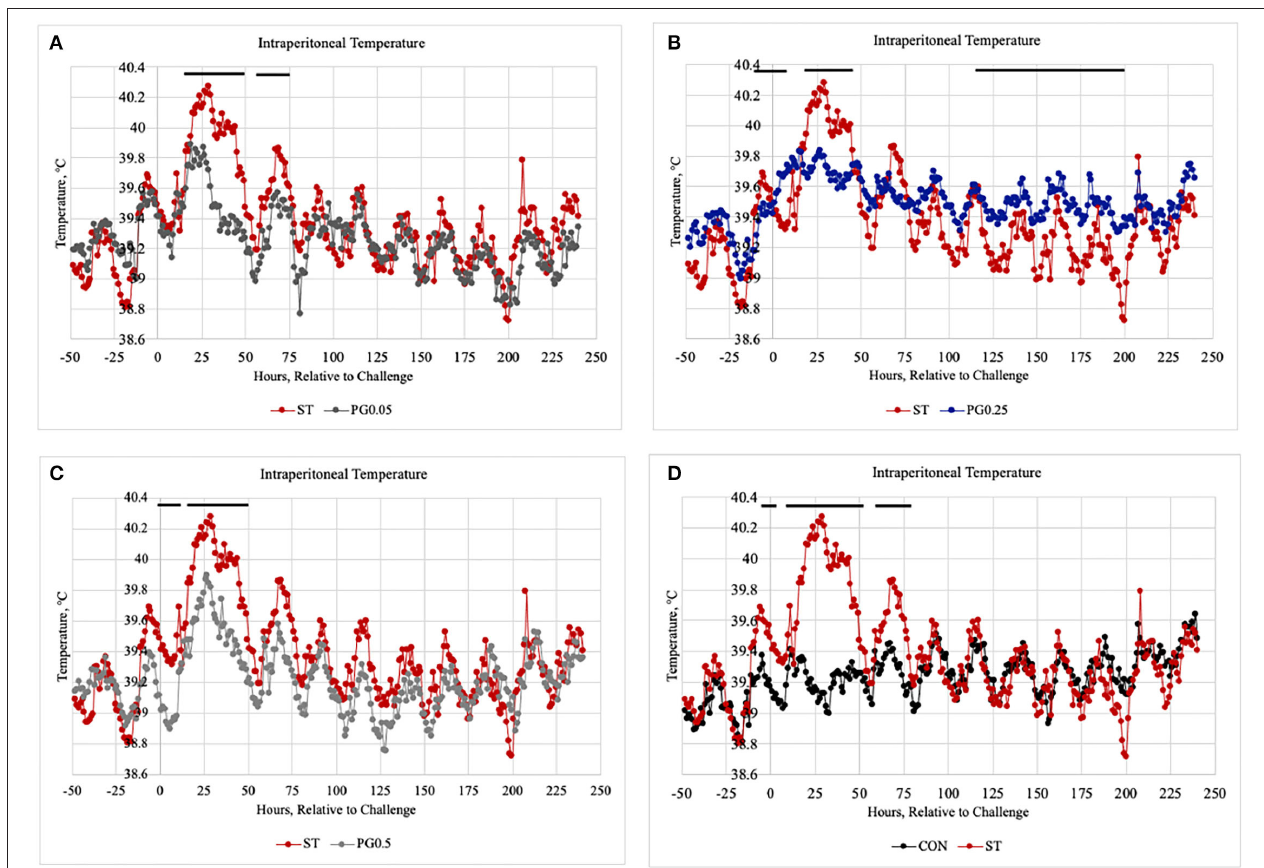
FIGURE 10 | The intraperitoneal temperature was measured every 5min and averaged to give an hourly temperature from 48 h prior to infection until 240 h post-infection when pigs were harvested, and temperature probes removed. (A–D) Separate treatments and make the figures clearer for the reader. (A) comparison of ST vs PG0.05, (B) comparison of ST vs PG0.25, (C) comparison of ST vs PG0.5, and (D) comparison of ST to CON. There was a treatment × time interaction ( P < 0.0001). There were treatment differences at hours 4–10, 20–45, and 81 ( P ≤ 0.0461) and treatment tendencies at hours 17, 19, 47, 48, 83, 181, 199, and 200 ( P ≤